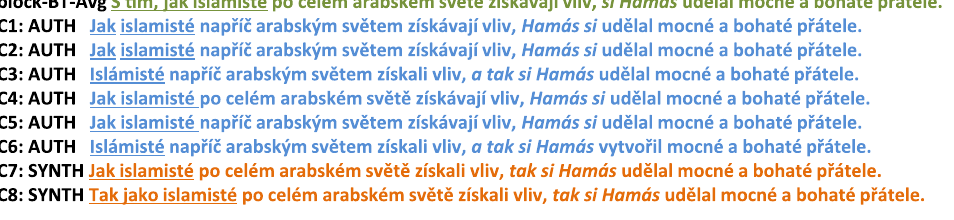
Fig. 7 Examples of novel Avg8 sentences. a A case where the translation resulting from checkpoint averaging is a crossover of translations present in AUTH and SYNTH blocks. All the mentioned translations are shown in Supplementary Fig. 17. b A case where the translation resulting from checkpoint averaging contains a phrase that is not the preferred translation in any of the averaged